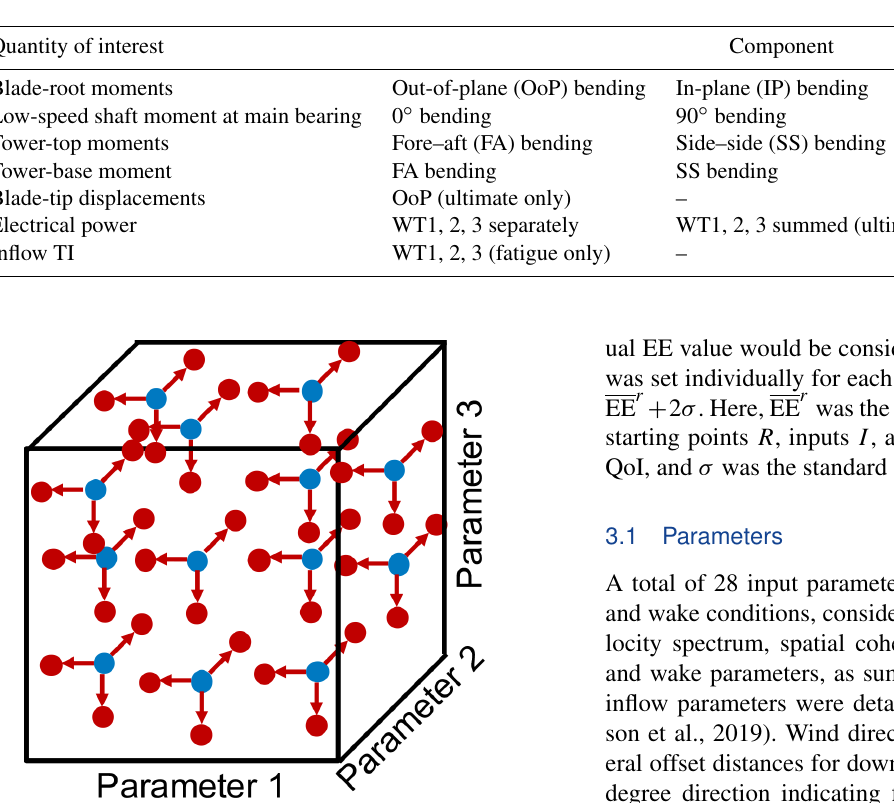
Figure 2. Potential sources of uncertainty in a wind turbine and wind farm load analysis. Includes wind inflow conditions, wake parameters, and the associated load QoI. Table 1. Quantities of interest and relevant vector components.